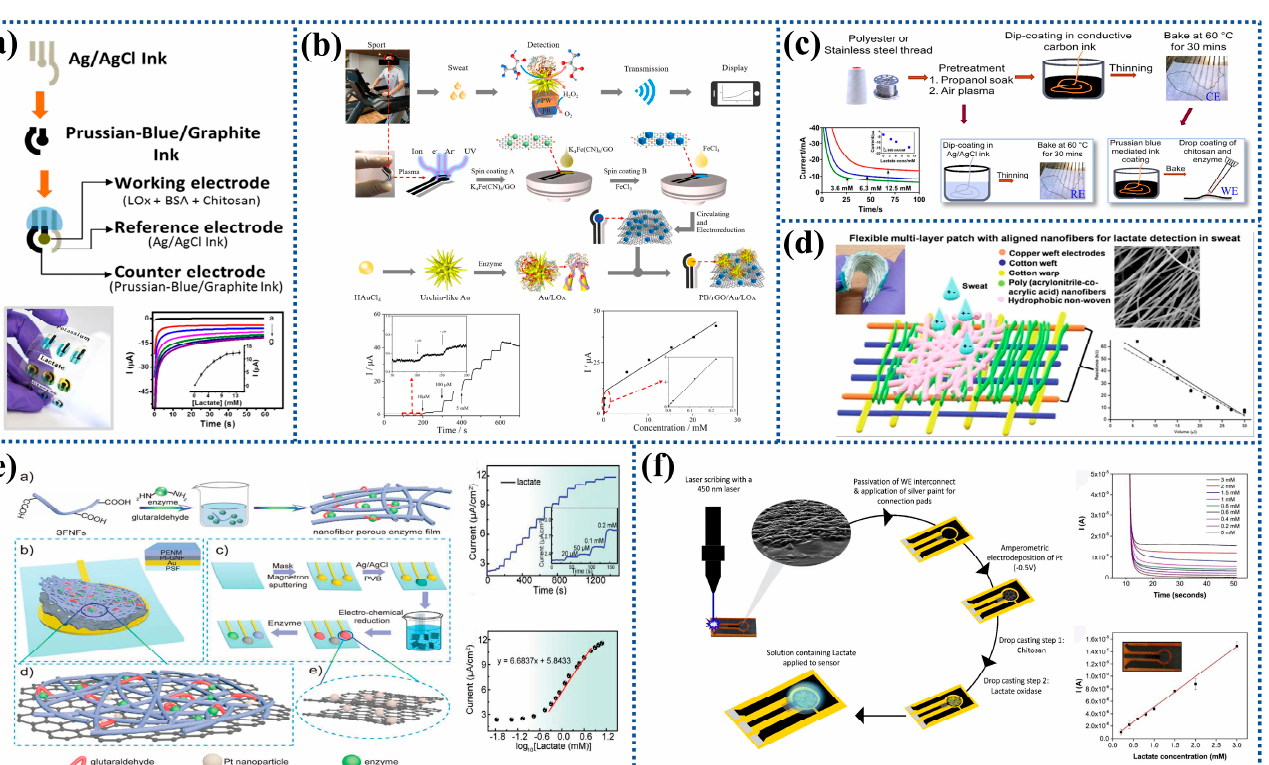
on − skin sweat lactate sensing. Reprinted with permission from ref. [72]. Copyright 2021 Wiley − VCH. ( f ) Electrochemical sensor for enzymatic lactate detection based on laser − scribed graphitic carbon. Reprinted with permission from ref. [73]. Copyright 2022 Elsevier.